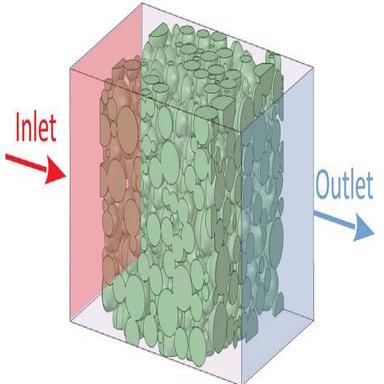
The computational domain channel for the fluid flow calculations.